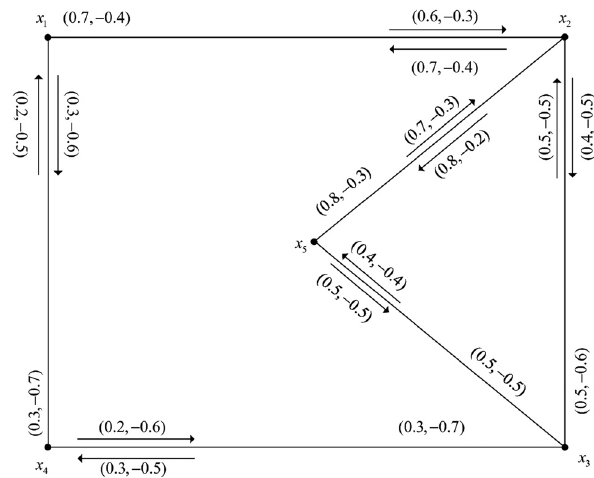
Figure 1: A BFIG with G CCI 2.6, −2.4 BFI ( ) ( )